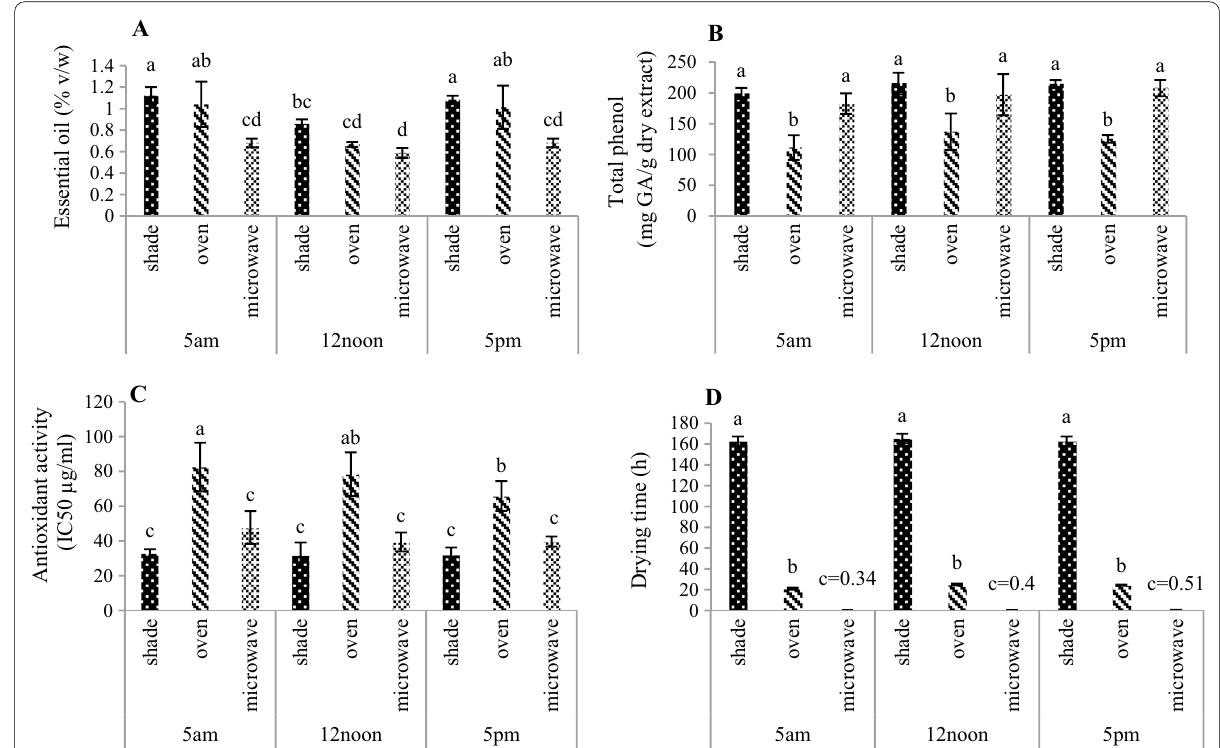
Fig. 1 Essential oil content ( A ), total phenol of extract ( B ), antioxidant activity of extract ( C ) and drying time ( D ) of Rosmarinus officinalis as affected by different harvesting times (5 am, 12 noon and 5 pm), and drying methods (shade, oven and microwave). Means with the same letter are not significantly different at p < 0.05 (Duncan’s